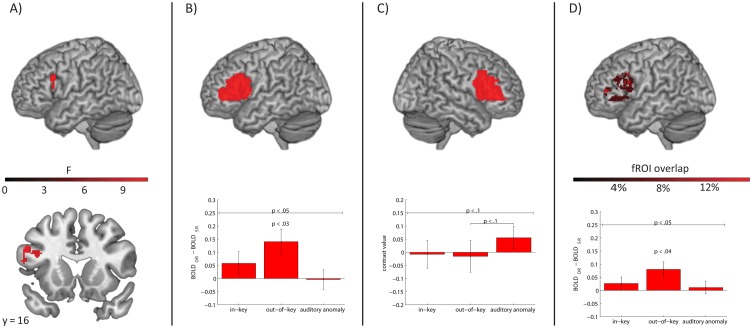
fMRI results.A) The language main effect (OR > SR) found in the whole-brain analysis (p < .005 uncorrected, cluster size = 87 voxels). B) Left hemisphere structural ROI. The BOLD effect of the linguistic manipulation is shown (OR—SR) with the associated p-value of a paired t-test above the bar. The significance level of the interaction effect is denoted above the line. Bars represent the activity difference (OR-SR) to sequences in which the stressed syllable of the critical word was sung in-key, out-of-key or unusually loudly (auditory anomaly). C) Right hemisphere structural ROI. The BOLD effect (compared to implicit baseline) is shown for each music condition. The p-value of a dependent t-test comparing two music conditions can be seen above the respective bars. The significance level of the music main effect is denoted above the line. D) Left hemisphere functional ROI. fROIs were individually defined in the left structural ROI. The inter-subject overlap in fROI locations is shown in the top panel. See methods for details. The BOLD effect is shown for the three different music conditions separately. Error = SEM. All p-values in structural ROI analyses are Bonferroni adjusted.